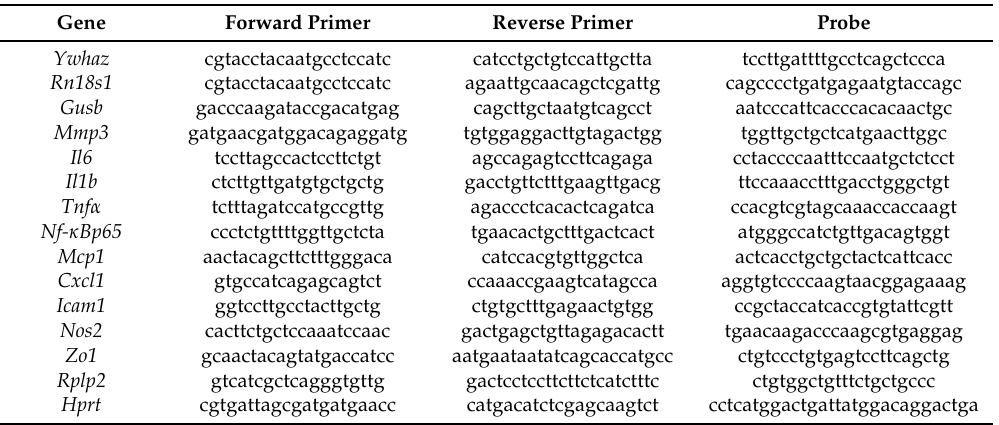
Table 1. Primer and probe sequences of the different genes used in